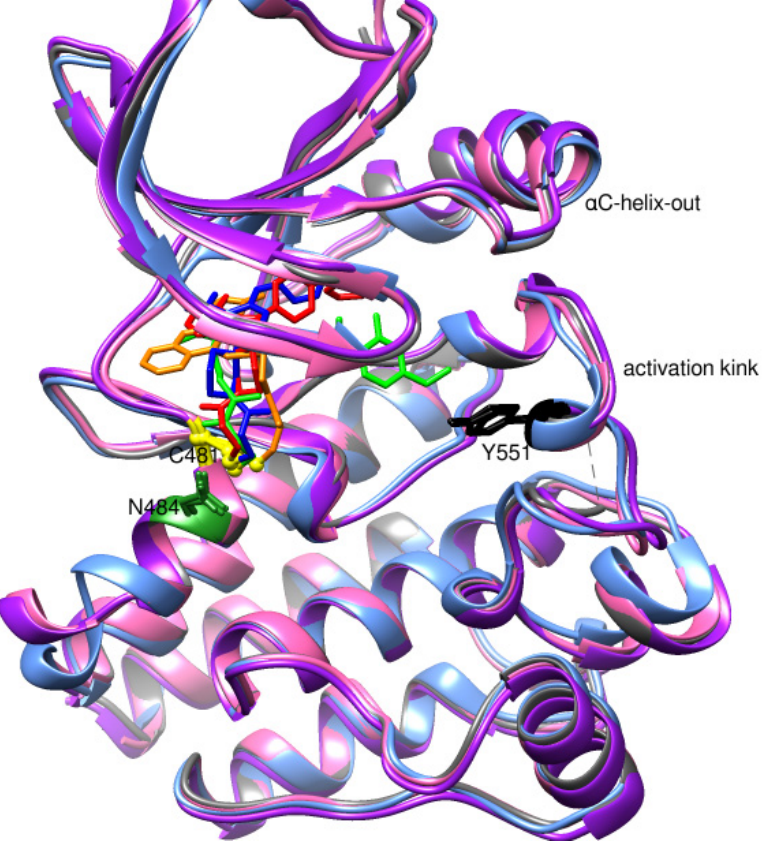
Figure 7. Superimposed 3D structures of novel covalent inhibitors bound to BTK-kinase domain. Protein: grey-ibrutinib-bound (5P9J), blue-LOU064-bound (6TFP), purple-2IE-bound (7R60), pink- TAK020-bound (7N5Y). Ligands: red-ibrutinib, green-LOU064, blue-2IE, orange-TAK020. α C-helix inactive out conformation and activation kink is visible in the other inhibitor-bound BTK confor- mation, similar to the ibrutinib-bound conformation.